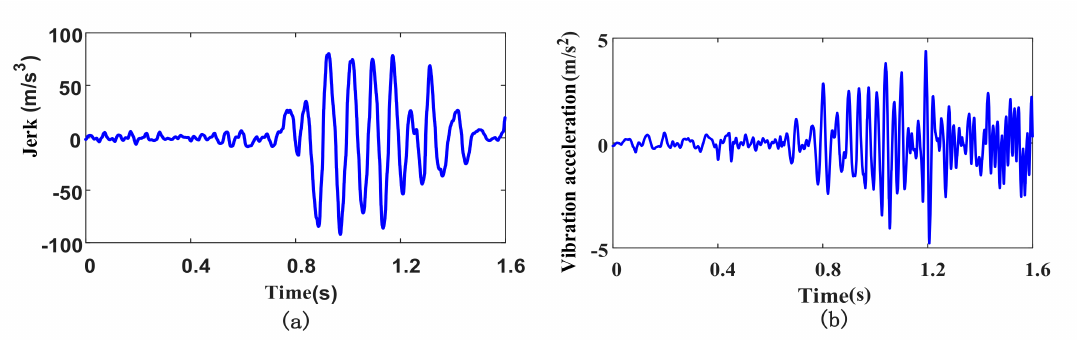
Figure 9. Jerk and vibration of power transmission: ( a ) jerk; ( b ) vibration